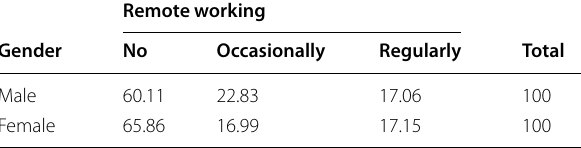
Results are reported in percentage